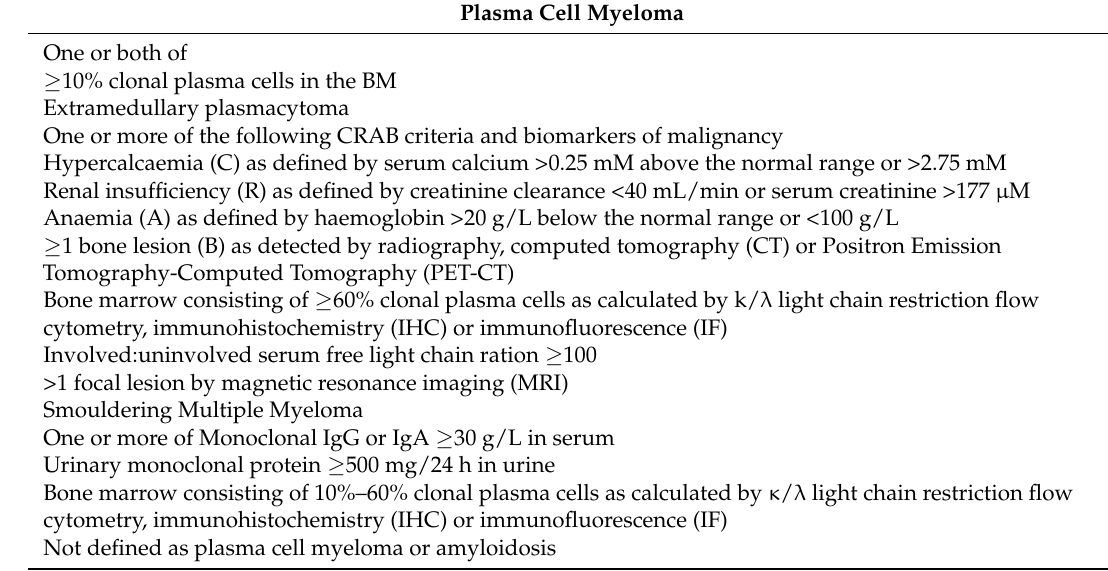
Table 1. International Myeloma Working Group 2014 Definition of SMM and PCM